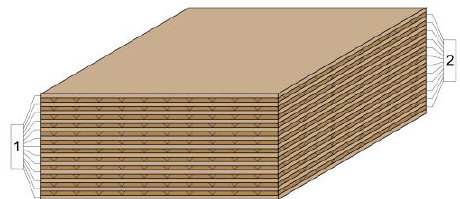
Figure 2. Multi-layer panel with a nominal thickness of 51 mm made of 13 layers of veneer and 12 layers of corrugated cardboard: 1. Rotary cut beech veneer, δ = 1.2 mm; 2. three-layer corrugated cardboard δ н = 6 mm.